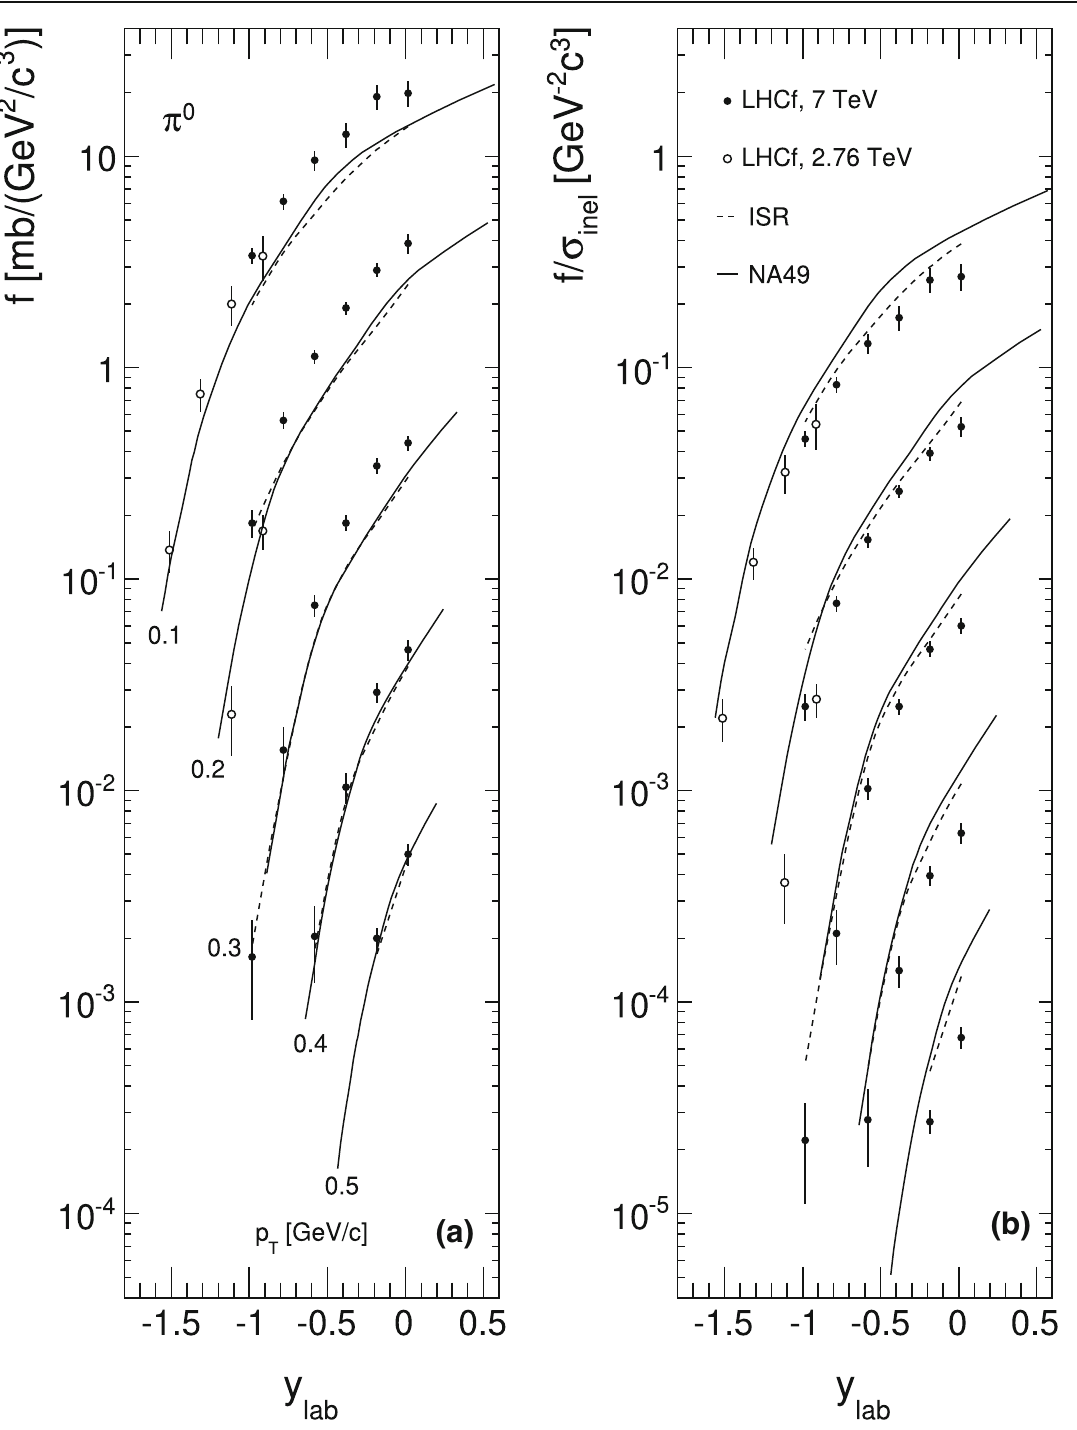
Fig. 110 π 0 cross sections as a function of p lab for p T = 0.1, 0.2, 0.3, 0.4, 0.5 GeV/c for NA49 and ISR (predictions) and LHC energies; a L f ( y lab , p T ) , b f ( y lab , p T )/σ inel . The distributions for different p T values are successively scaled down by factor of 1/3 for better